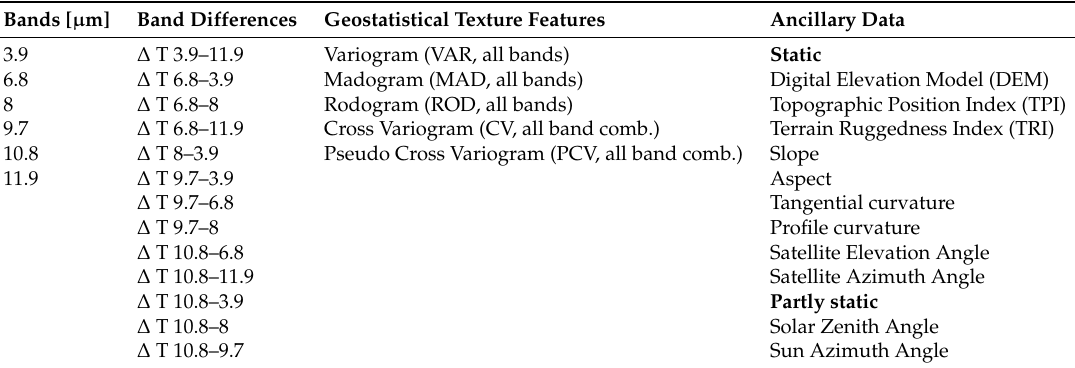
Table 3. Overview of the predictors used for the RF feature selection and